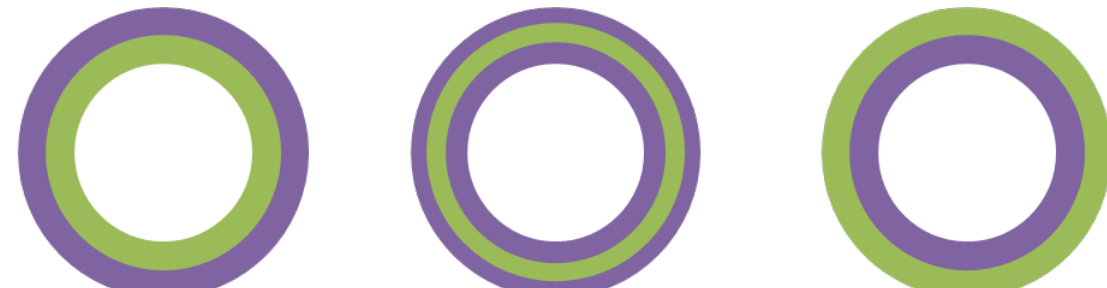
Figure 1. ( A ) Set-up of electrospinning of the vascular graft. Generally, a single polymer solution was eluted for multi- layered and single-layered vascular grafts, with the exception of co-electrospinning, in which two polymer solutions were eluted simultaneously. ( B ) Schematic design of multi-layered grafts, where PLCL is indicated by green color and PDO is indicated by purple color.